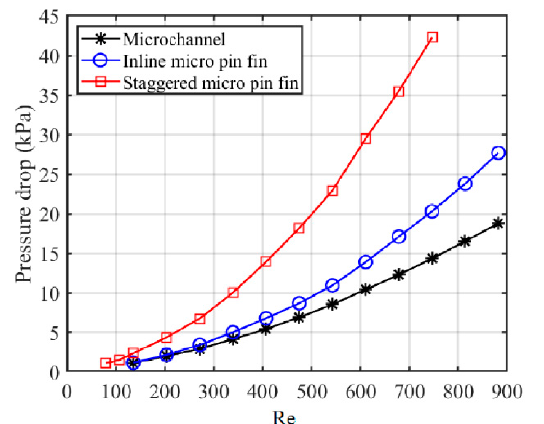
( b ) Figure 8. Temperature distributions along the centerline of the simulated power IC at ( a ) Re = 339.3, ( b ) Re = 678.7. Besides, it is found that the rising trends of the temperature curves of MCHS and I-MPFHS in Figure 8 stop at the last points. The reason for this phenomenon is that the last temperature sensor is very close to the border of the heated area. At the border of the heated area, a part of the input heating power is conducted to the unheated area, resulting in an apparent temperature reduction. For S- MPFHS, the heat transfer performance of the convective surfaces is high so that the lateral conduction is not severe. As a result, the temperature reduction near the last temperature sensor in S-MPFHS is much lower than those in MCHS and I-MPFHS. The pressure drop between the inlet and the outlet is another important parameter in evaluating the performance of a heat sink. Figure 9 shows variations of the pressure drop with Re. It shows that the pressure drop of S-MPFHS is much higher than that of MCHS and I-MPFHS because of the tortuous flow path, which not only increases friction resistance by interrupting the development of the boundary layers but also brings on high pressure resistance by generating flow separation in the back of the micro pin fins. As for I-MPFHS, the pressure resistance takes a low proportion of the total